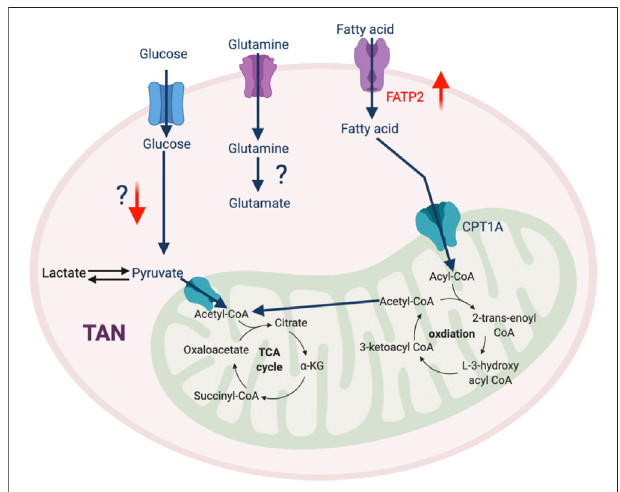
FIGURE 4 | The metabolic features of TADC. The tumor-in fi ltrating TADC upregulate fatty acid metabolism to support their immunosuppressive function while the role amino acid and glycolysis pathway in not yet clear. “ ↑ ” indicates “ increase. ” CPT1A, Carnitine Palmitoyltransferase 1A.